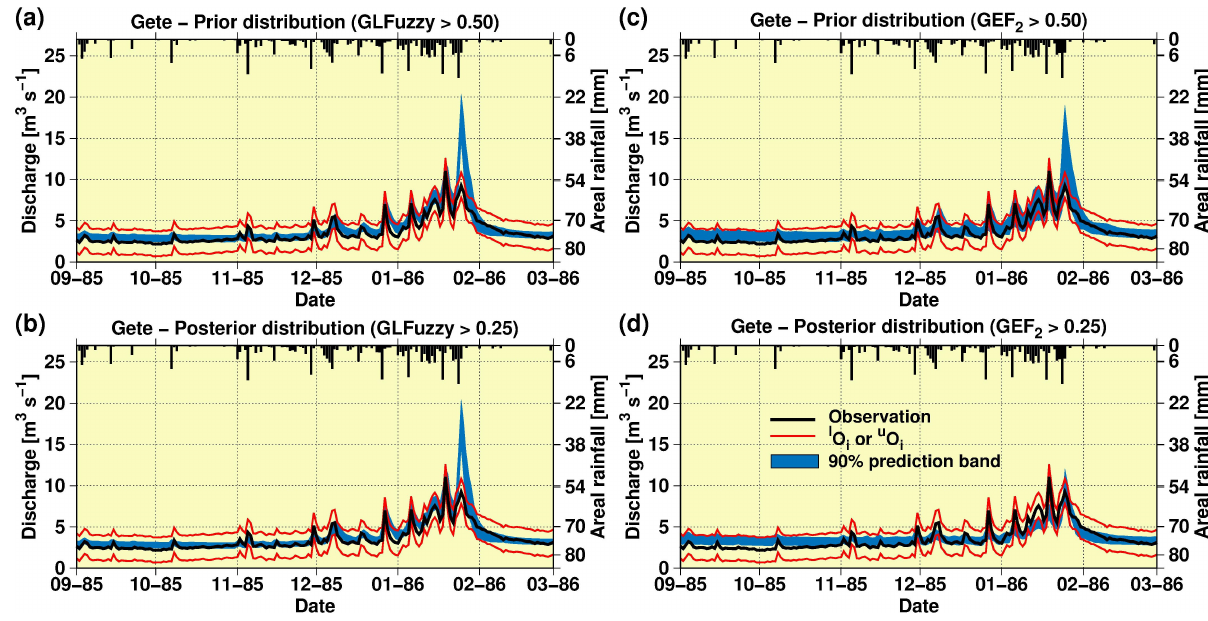
Figure 5. 7. Figure 7. Ninety percent streamflow prediction limits (the Gete station) in the validation period [1 September 1985–1 March 1986], using both prior (likelihood target was 0.50) and posterior (likeli- hood target was 0.25) likelihood distributions, after conditioning based on observed streamflow at the three study gauging stations (i.e., the multi-site test) and considering the H-Q data uncertainty: ( a , b ) using the LFuzzy likelihood measure and ( c , d ) using the EF 2